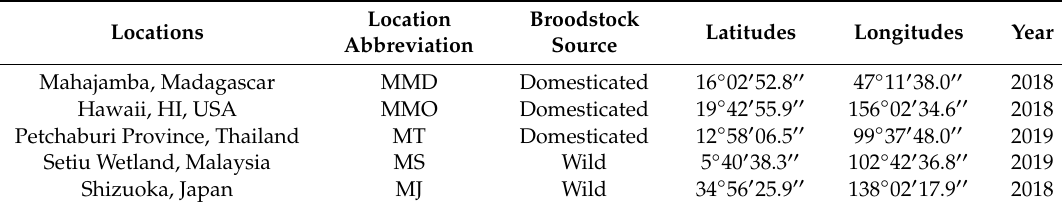
Table 1. Summary of the sampling information of Penaeus monodon population collected from the di ff erent Indo-Pacific